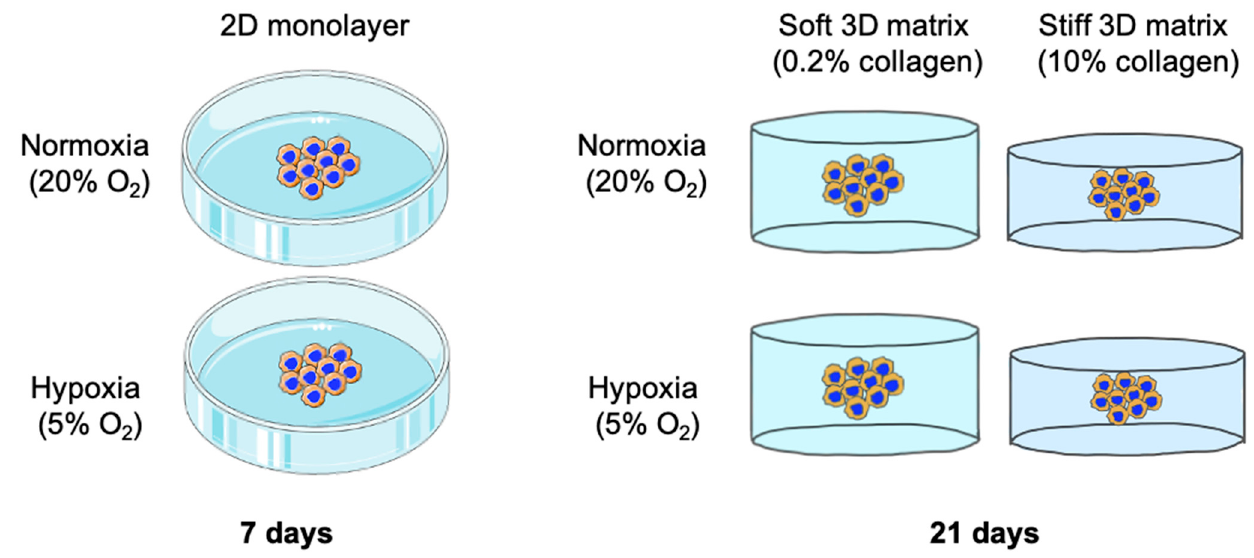
Figure 1. Experimental set up for HT-29 and MDA-MB-231 cells grown in 2D and 3D. For the 2D set up, cells were grown in either 21% or 5% O 2 for 7 days and analysed for morphology, invasion and gene expression. For the 3D set up, cells were grown in either 21% or 5% O 2 and in either a soft (0.2% collagen) or stiff (10% collagen) matrix for 21 days. After this, the samples were subsequently analysed for morphology and gene expression. Adapted using SMART-Servier Medical ART.